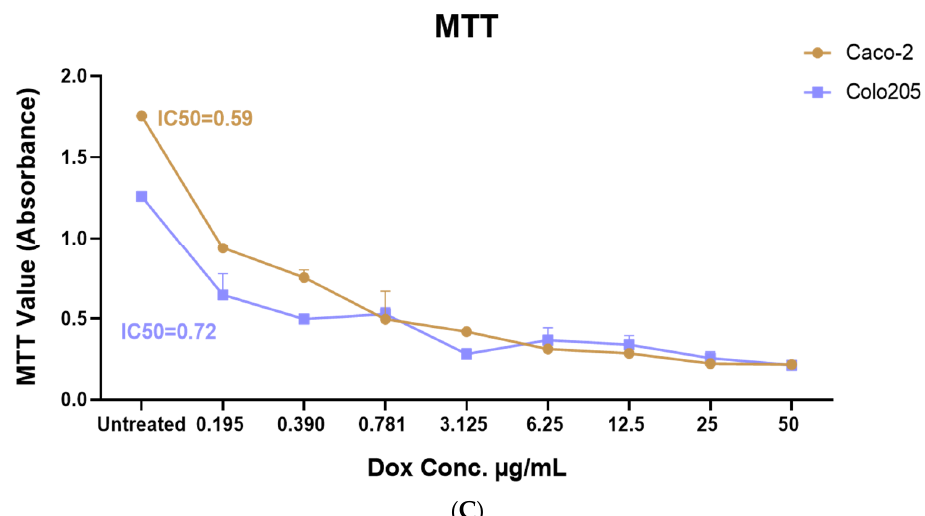
Figure 2. Cell viability MTT assay of Caco-2 and COLO-205 colon cancer cells and hGFs after treatment with the following: ( A ) increasing concentration of aqueous Drimia maritima bulb extract (0.122–31.25 µg/mL); ( B ) Proscillaridin (0.0024–1.32 µg/mL); ( C ) Doxorubicin (from 50 to 0.195 µg/mL). The IC 50 values were calculated using log-probit analysis. Each value is presented as the mean ± SD of an average of three independent experiments.